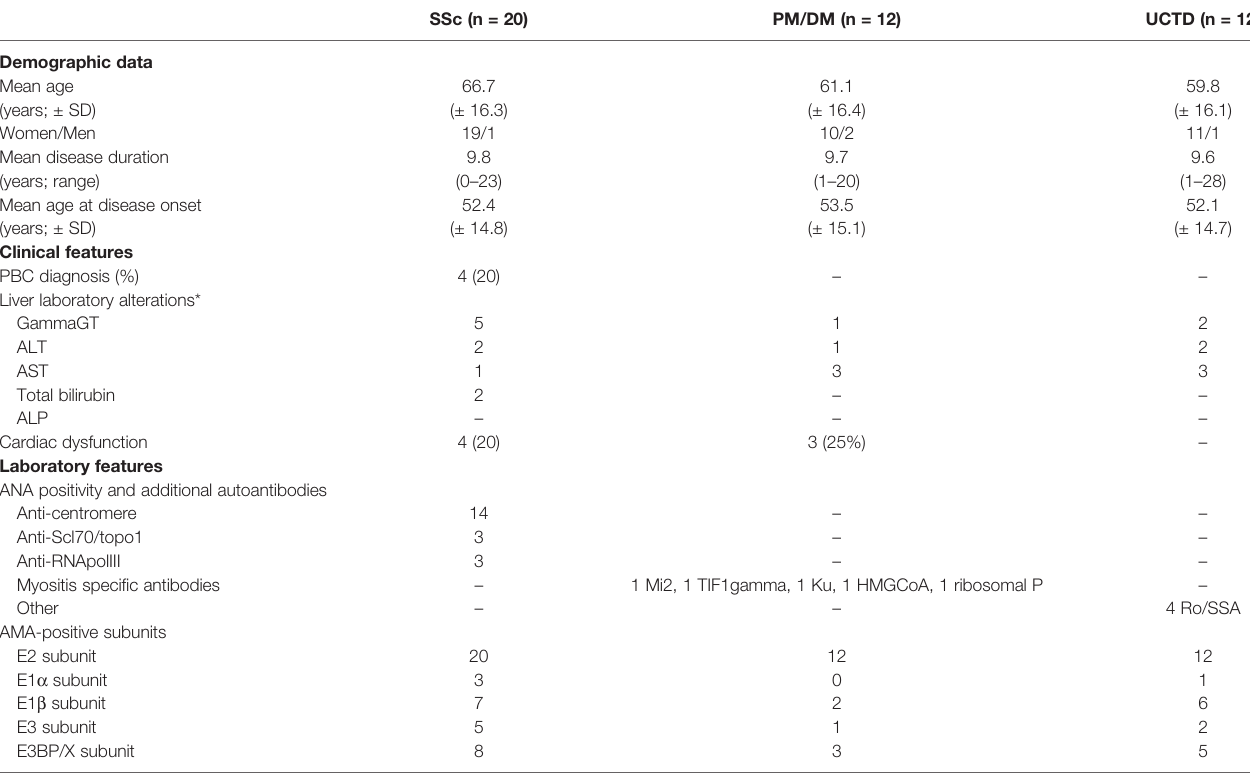
TABLE 1 | Main feature data of the 44 rheumatic patients with cytoplasmic reticular pattern by HEp-2 IIF analysis, then tested for AMA components.